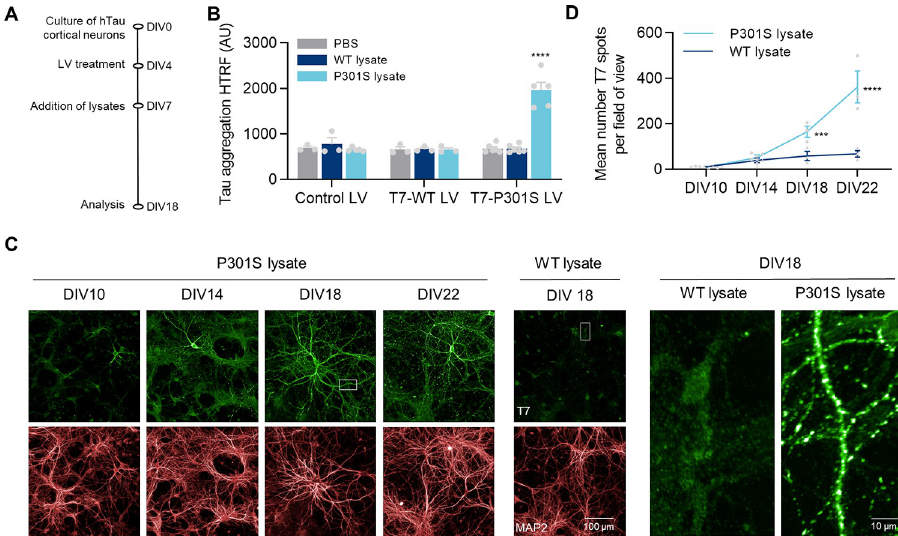
Fig 1. Designing a neuronal seeding-based model of tau accumulation. A) Diagram of experimental design. B) Tau aggregation HTRF in DIV18 lysates from cells treated with control, T7-WT tau or T7-P301S tau LV at MOI 5, and lysates from WT or P301S mice at 166pg/cell, or PBS as a vehicle control. Data shown as mean ± SEM, n = 3–4 independent experiments. Assay background = 627 ± 50. One-Way ANOVA with Dunnett’s multiple comparisons test. All conditions tested against Control LV + PBS. C) Representative images from hTau primary neurons treated with T7-P301S LV and WT or P301S brain lysates. Cells were fixed at the indicated DIVs. Left: zoom images of the areas highlighted in white. D) Quantification of the number of Triton-insoluble T7 inclusions in hTau primary neurons treated as in C. Data shown as mean ± SEM, n = 3–4 independent experiments. Two-Way ANOVA with Sidak’s multiple comparisons test, comparing WT vs P301S brain lysate for each DIV.